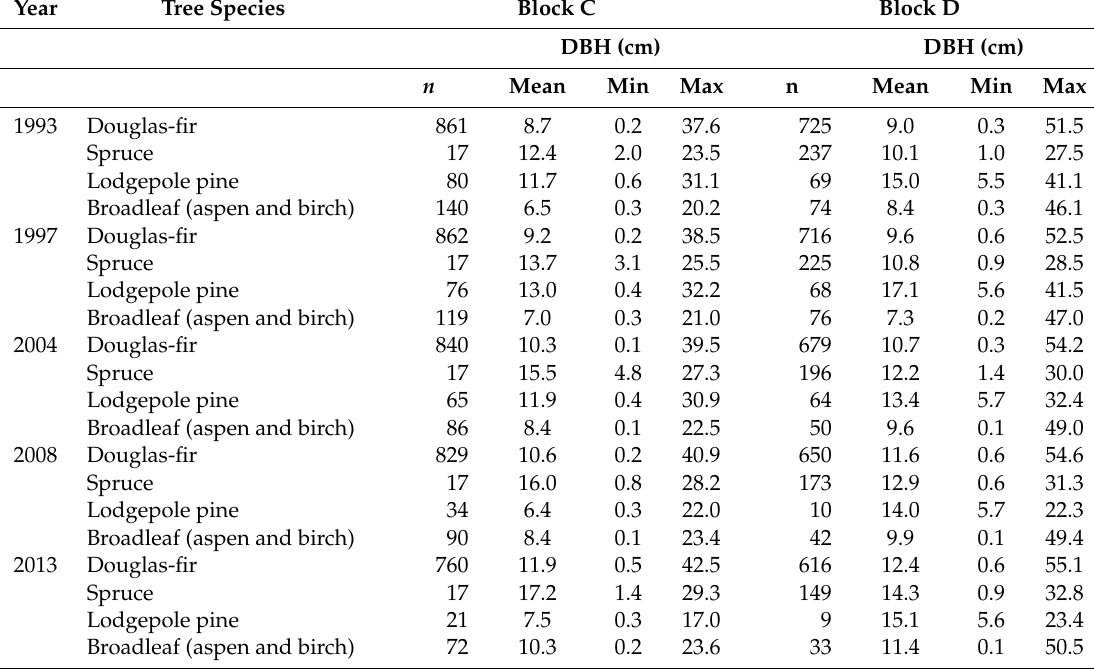
Table 1. Summary statistics (number of trees (n), and mean, minimum (Min), and maximum (Max) diameter at breast height (DBH)) by block, measurement year, and tree species or species